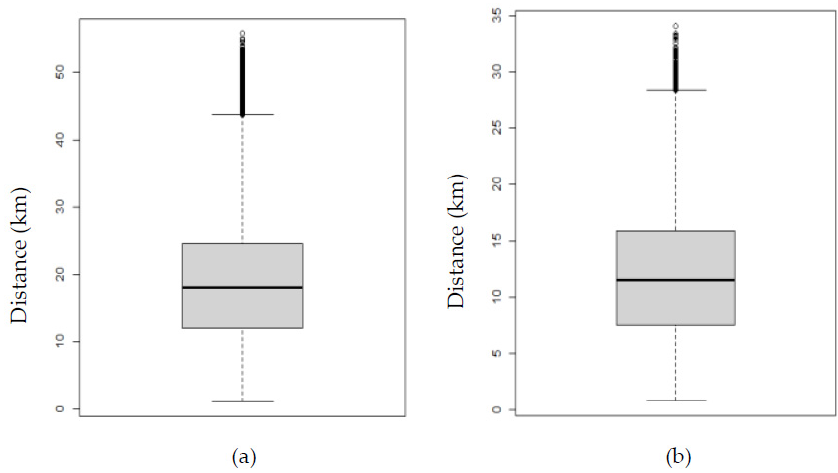
Figure 9. ( a ) represents a box plot of the transit travel distance distribution; ( b ) represents a box plot of the Euclidian travel distance distribution.